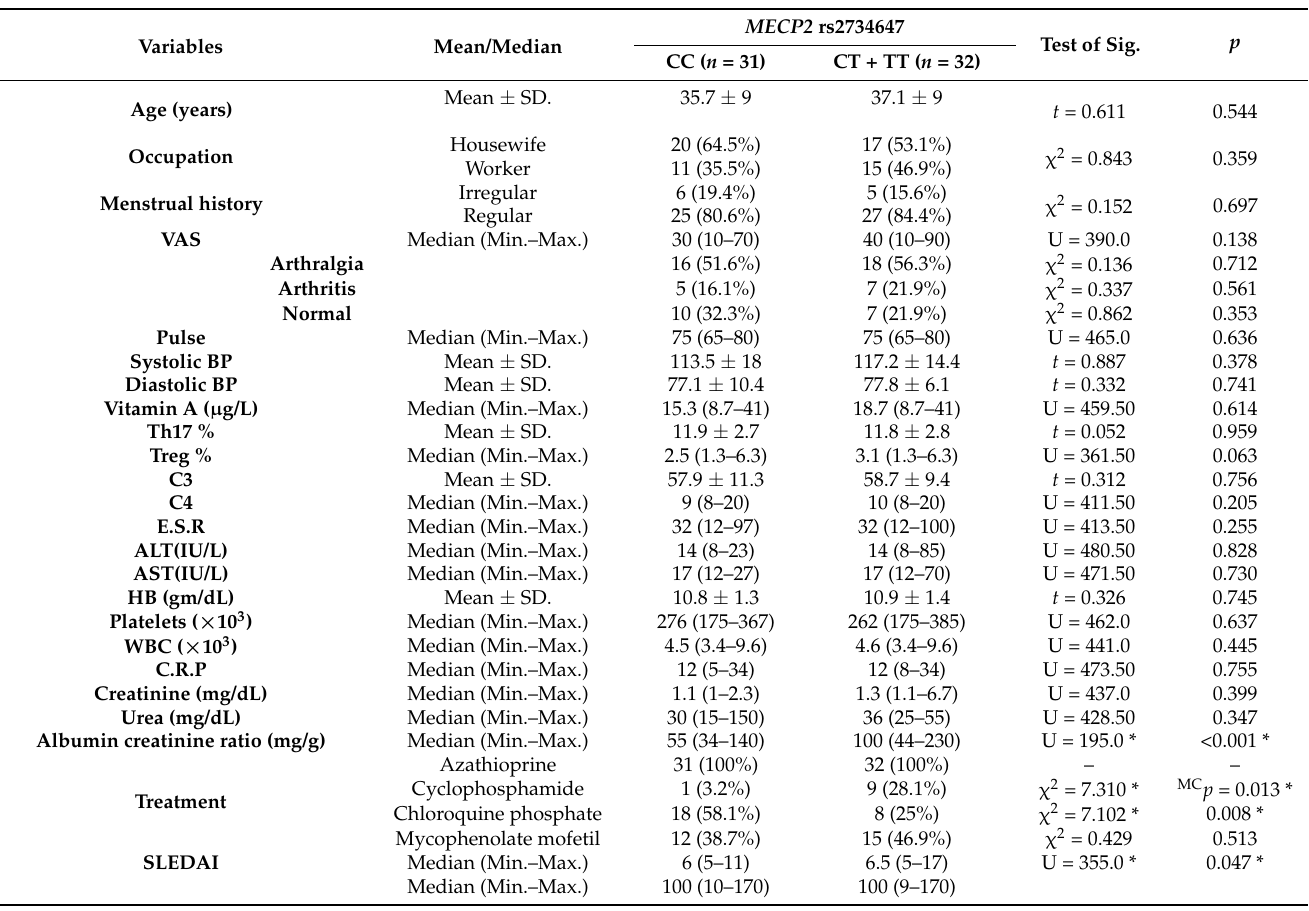
Table 5. Relationships between MECP2 rs2734647 genotypes and different parameters in SLE patients with nephritis ( n =